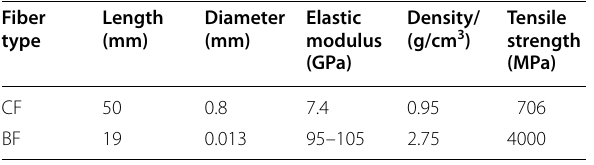
Table 2 Parameters of each group of specimens.